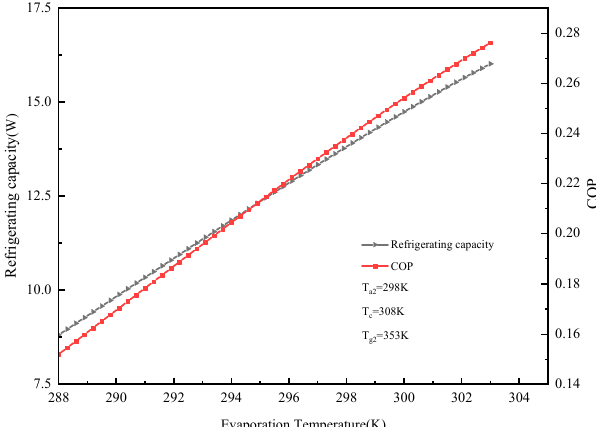
ff ect of evaporation temperature on refrigeration capacity and Figure 9. Effect of evaporation temperature on refrigeration capacity and COP. Figure 9. E